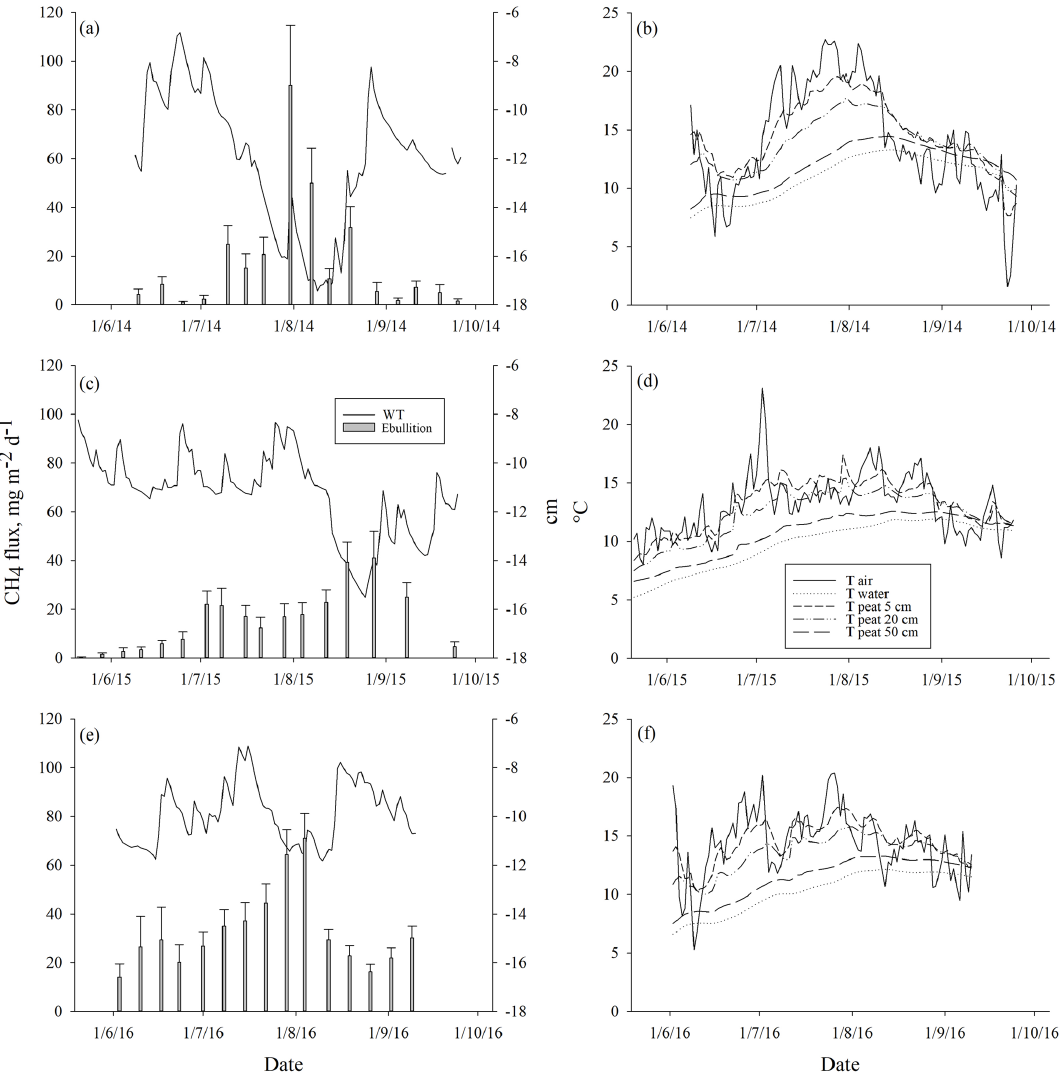
Figure 4. Mean weekly methane ebullition with standard error of the means from all surfaces compared to water table (WT) (a, c, e) , and air, water, and peat temperatures at the depths of 5, 25 and 50cm (b, d, f) measured in Siikaneva bog in the years (a–b) 2014, (c–d) 2015 and (e–f)